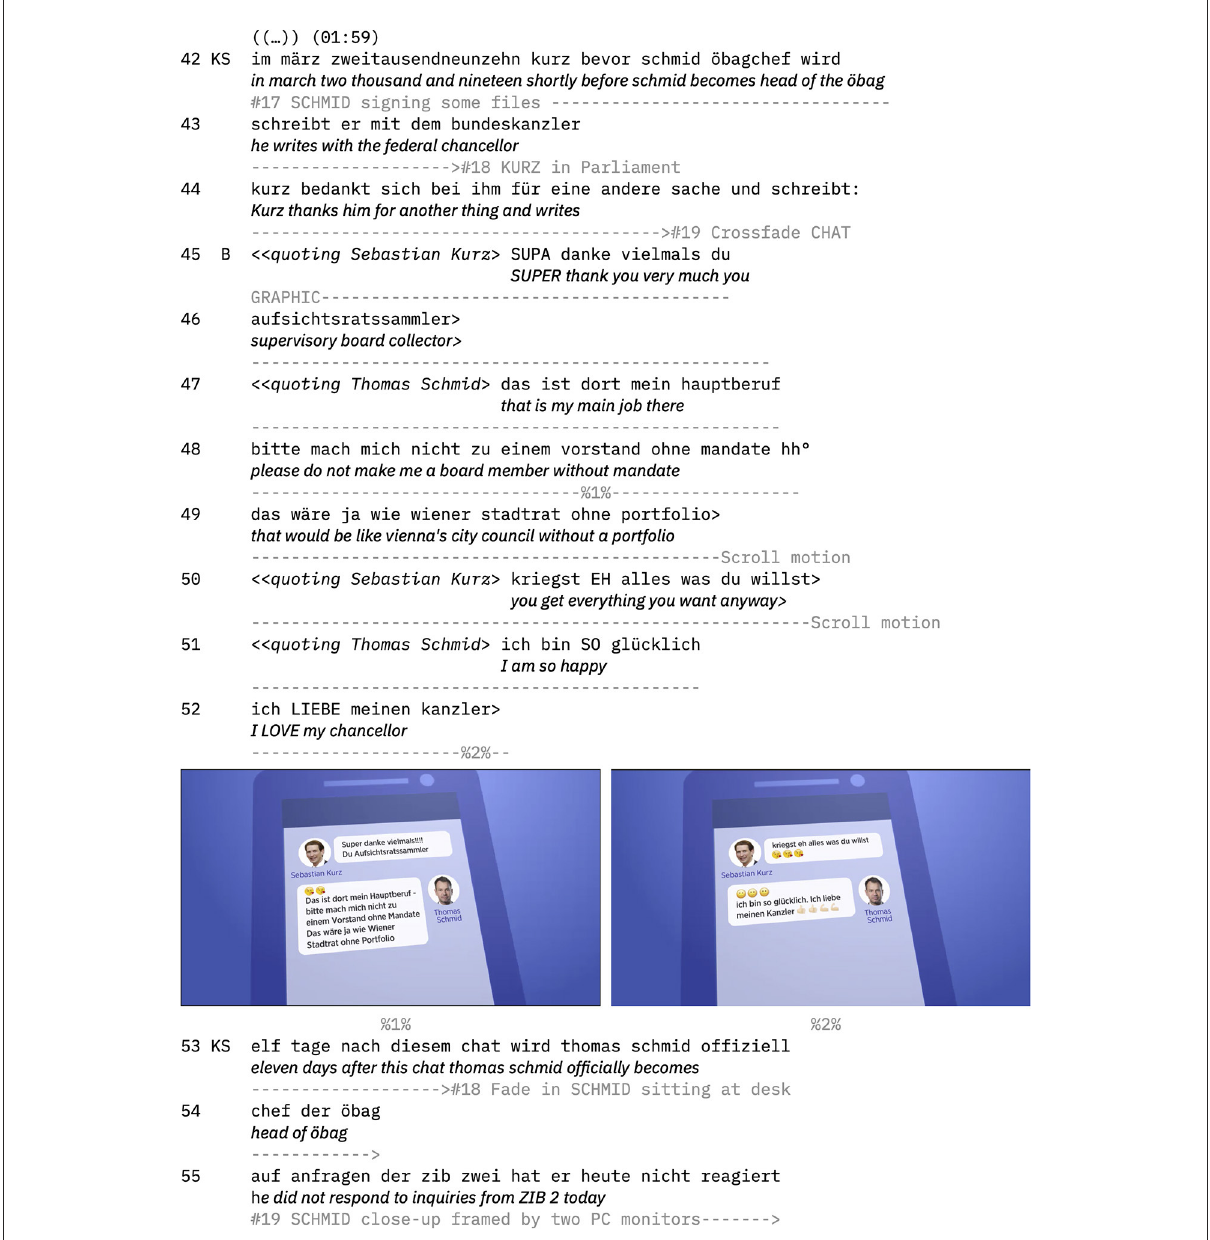
FIGURE4 Transcript of a multimodal reenactment of a IM chat fragment. (ZIB 2 am Sonntag, broadcast on March 28, 2021 at 9:48